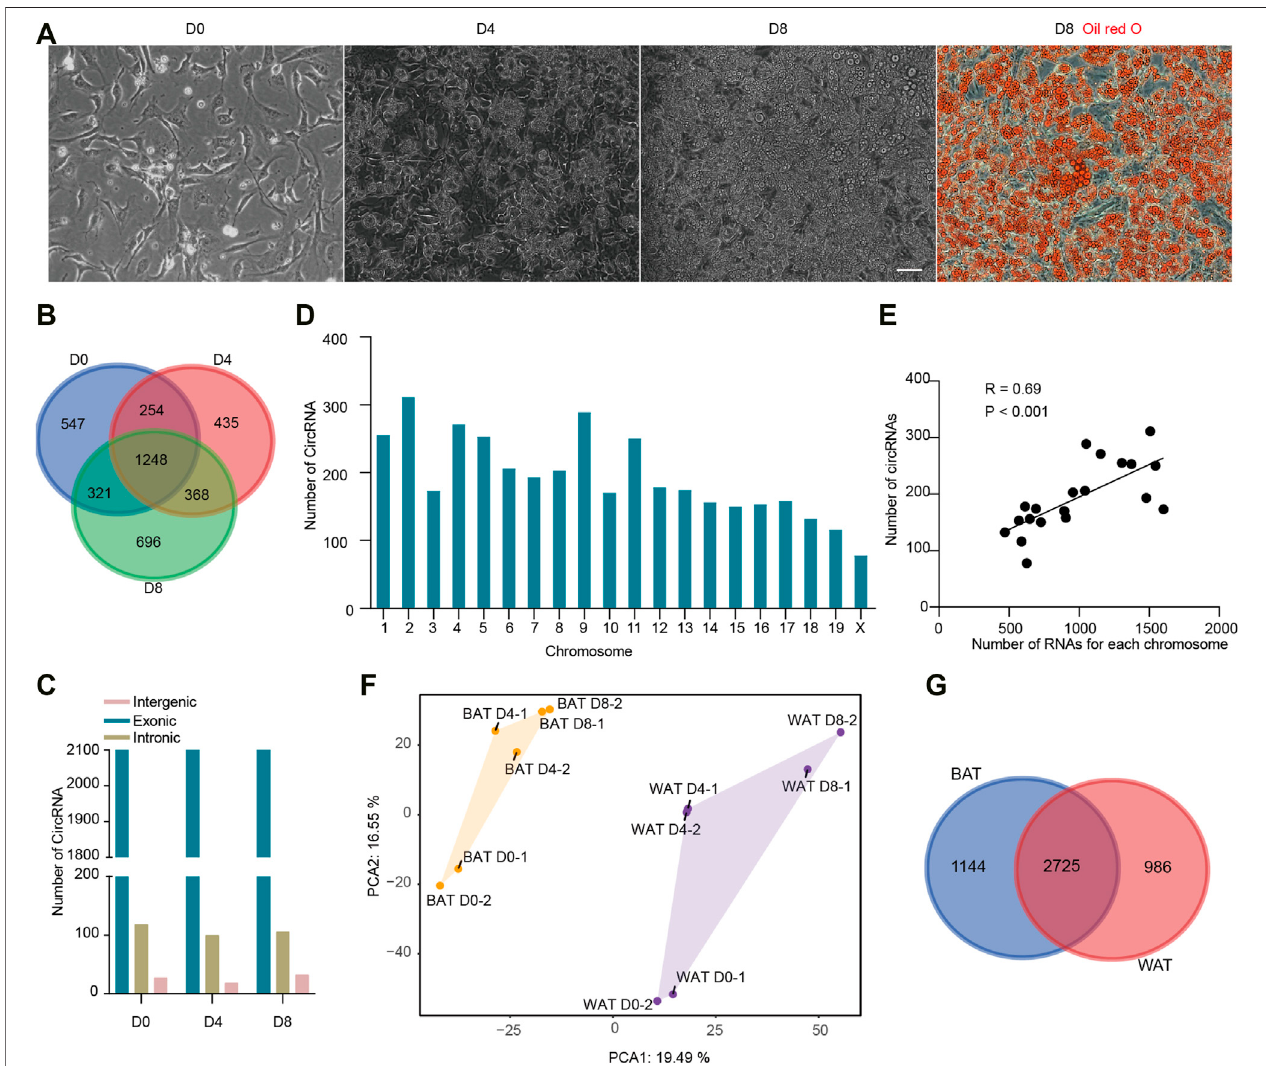
FIGURE 1 | Identi fi cation and characterization of circRNAs in brown adipogenesis. (A) Representative pictures of BAT pre-adipocytes differentiation. Scale bar (cid:1) 20 µm. (B) The number of CircRNAs identi fi ed during BAT pre-adipocytes differentiation. (C) The number of circRNA based on back-splicing regions in each adipogenesis stage. (D) The number of circRNAs derived from each chromosome. (E) Correlation of circRNA and mRNA number from the same chromosome. (F) Principal Component Analysis(PCA) ofcircRNA expression during BATand WAT pre-adipocytesdifferentiation. (G) VenndiagramsofcircRNAs expressed in BAT and WAT